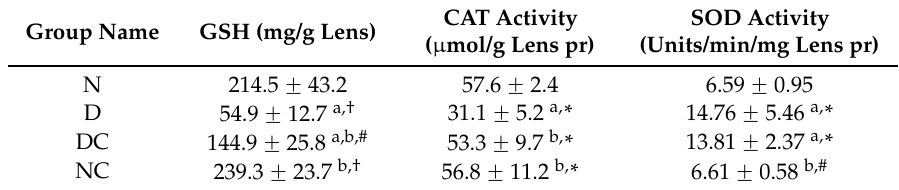
Table 2. The effect of crocin(s) on the glutathione content and the activities of antioxidant enzymes in the rats lenses.